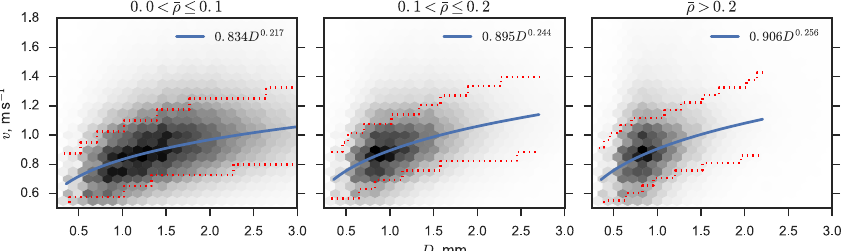
Figure 9. Probability densities of (D,v) in three ensemble mean density ranges ( [ ρ ] = gcm − 3 ). Dashed lines mark the full width at half maximum KDE in each diameter bin. Power-law functions are fitted for data between those lines.